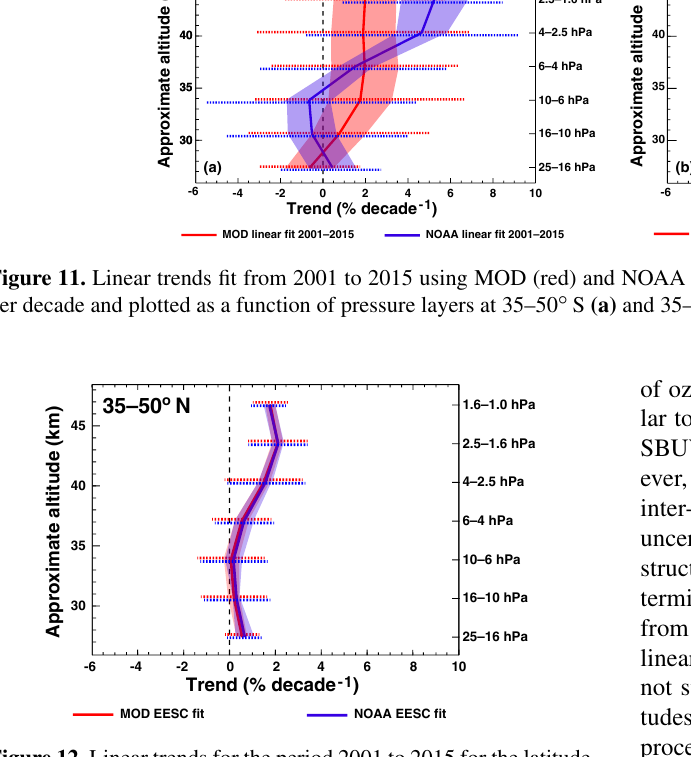
Figure 12. Linear trends for the period 2001 to 2015 for the latitude bin from 35–50 ◦ N obtained by fitting EESC over the entire time period from 1979 to 2015. Shading and uncertainties same as in Fig.